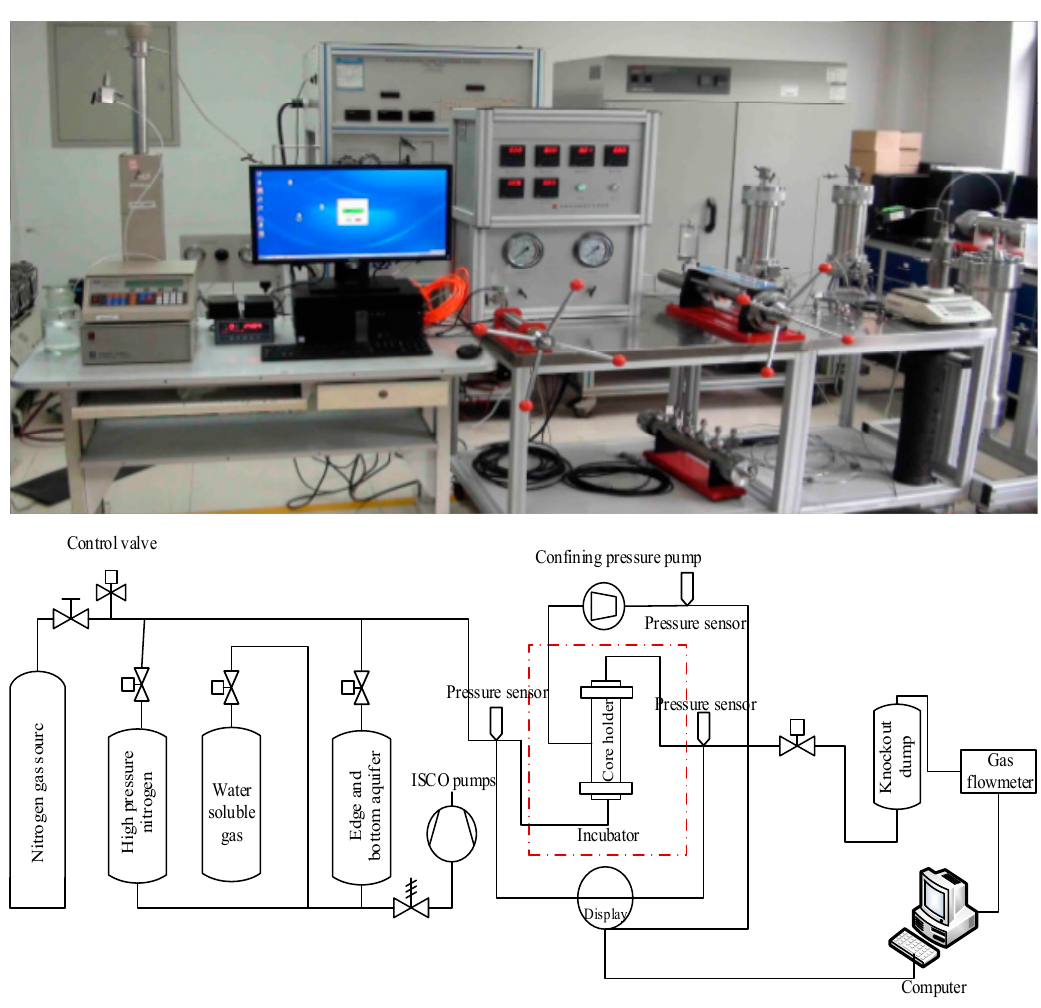
Figure 1. Experimental system of water invasion in gas reservoirs with edge and bottom aquifer.